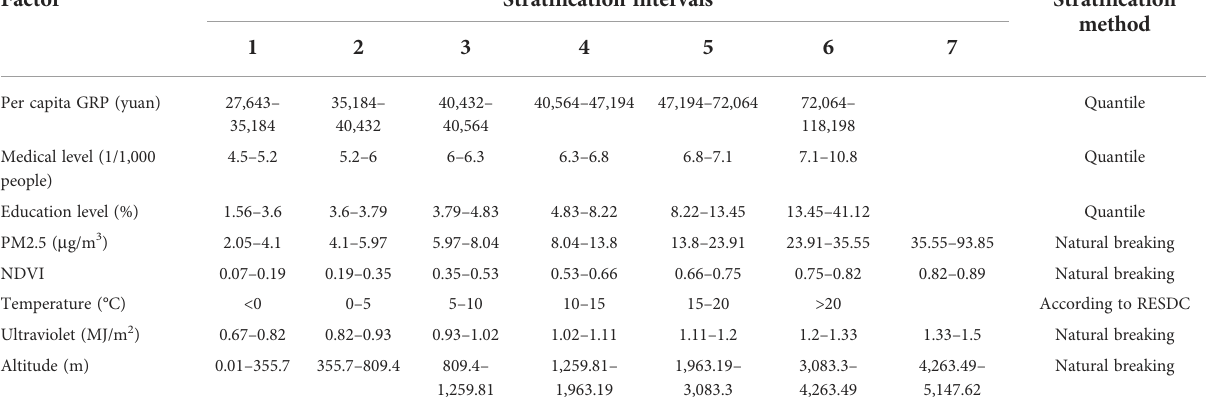
TABLE 1 Classi fi cation results and strategies of nine